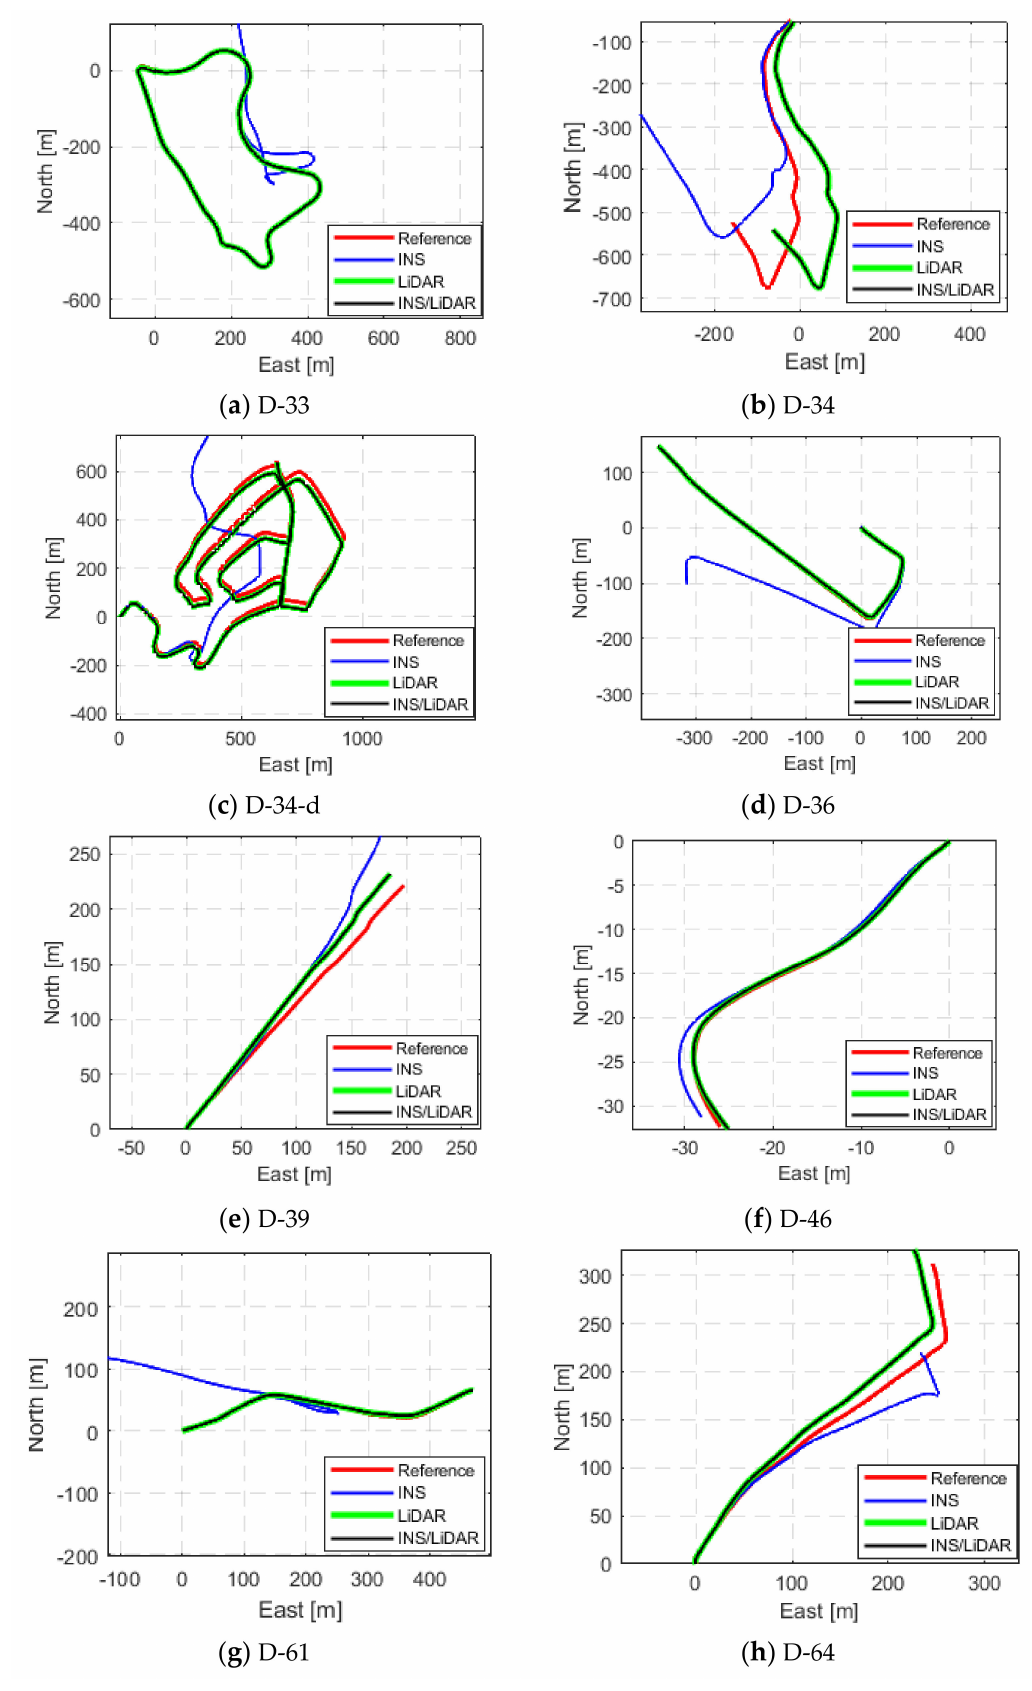
Figure 10. Complete GNNS signal outage: comparison of trajectories (D-33 to